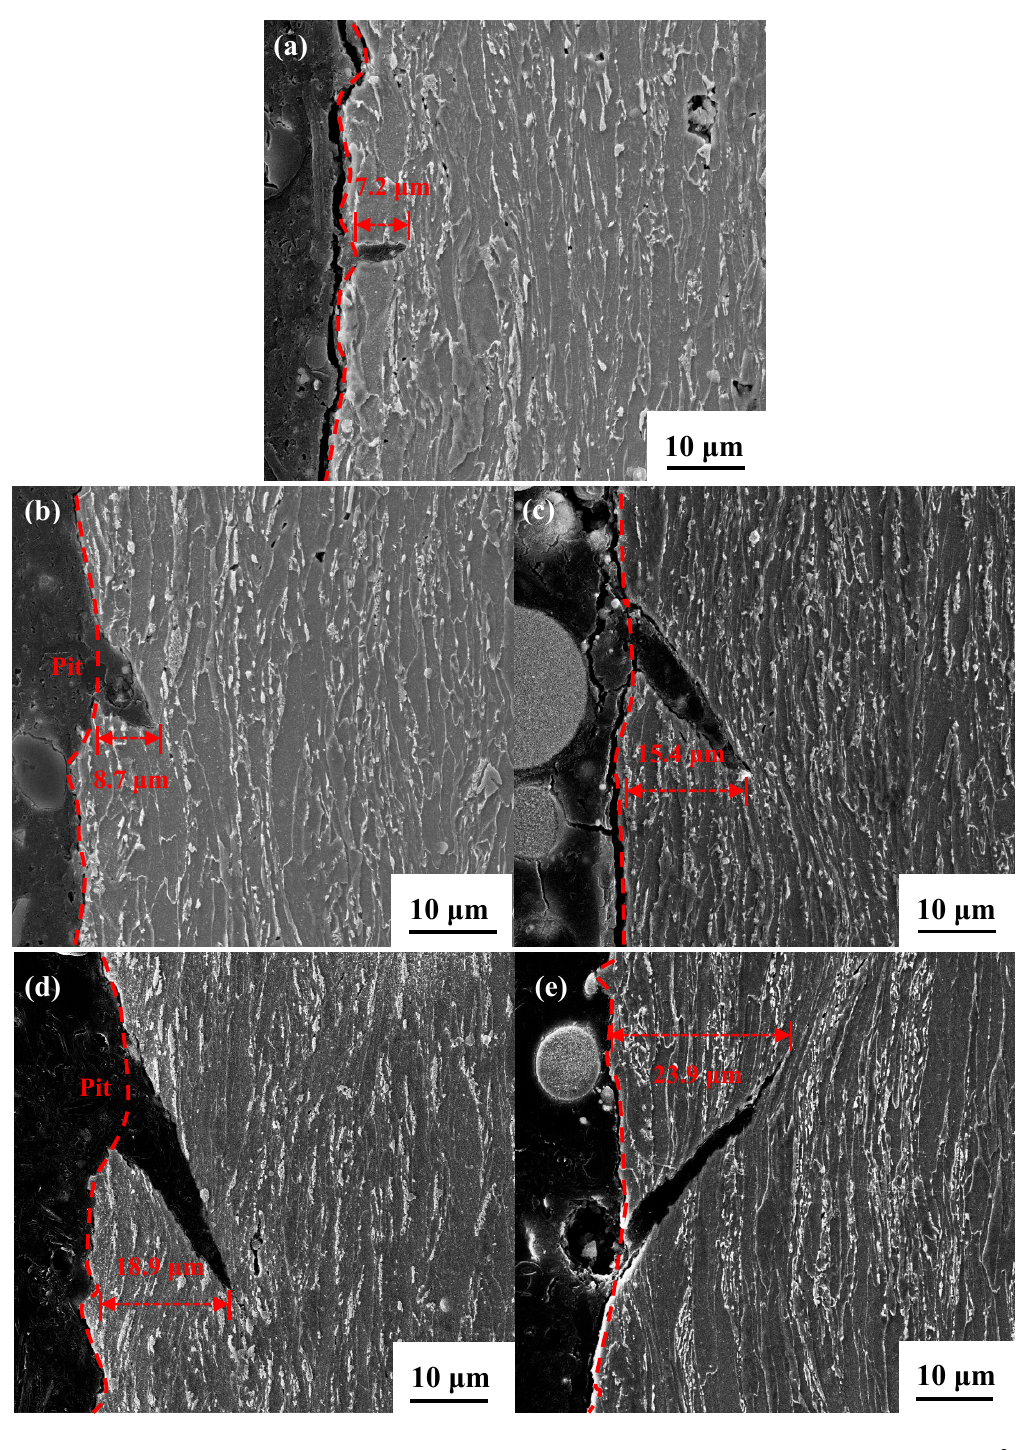
Figure 12. Cross-sectional fracture morphologies of the X70 steel at various AC densities of ( a ) 0 A/m 2 ; ( b ) 10 A/m 2 ; ( c ) 30 A/m 2 ; ( d ) 50 A/m 2 ; and ( e ) 100 A/m 2 in simulated seawater.